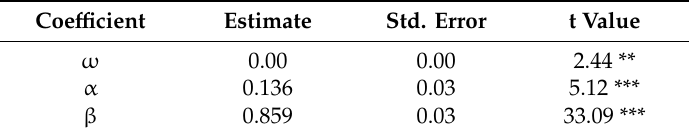
Table 4. Estimation Results of the GARCH Model in the